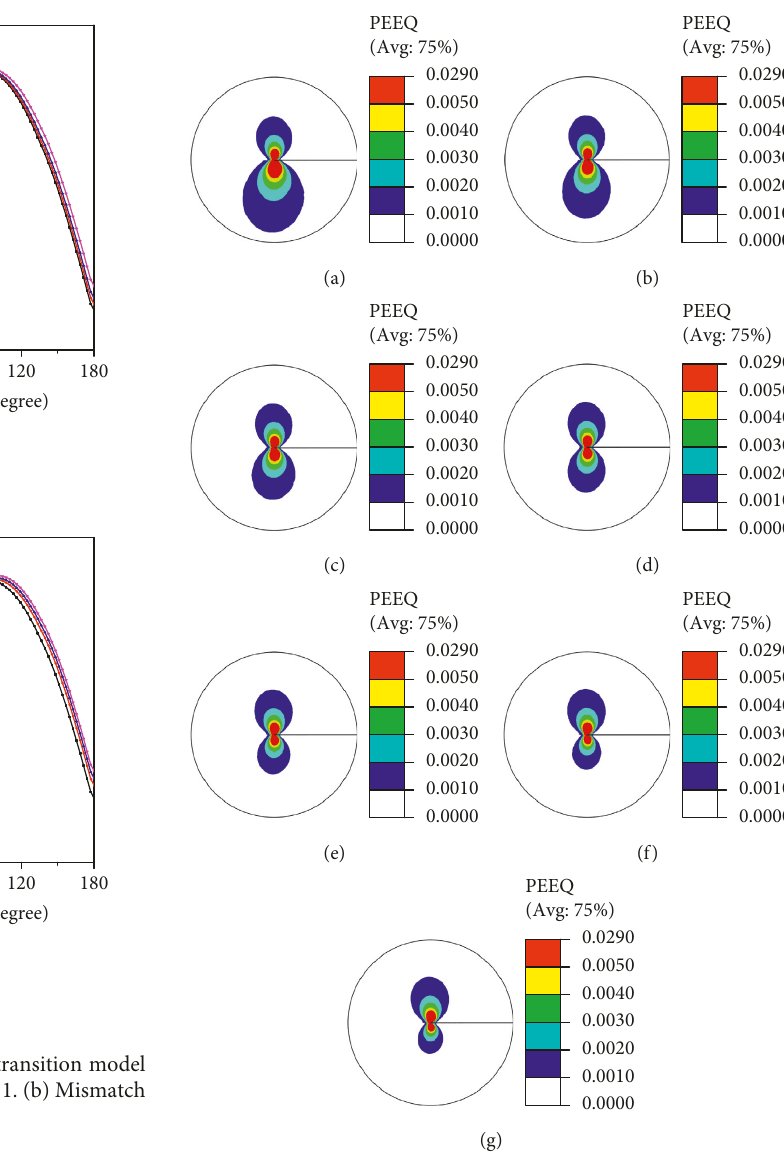
Figure 15: The equivalent plastic strain contour of “sandwich” material structure model around crack tip. (a) M � 0.7. (b) M �